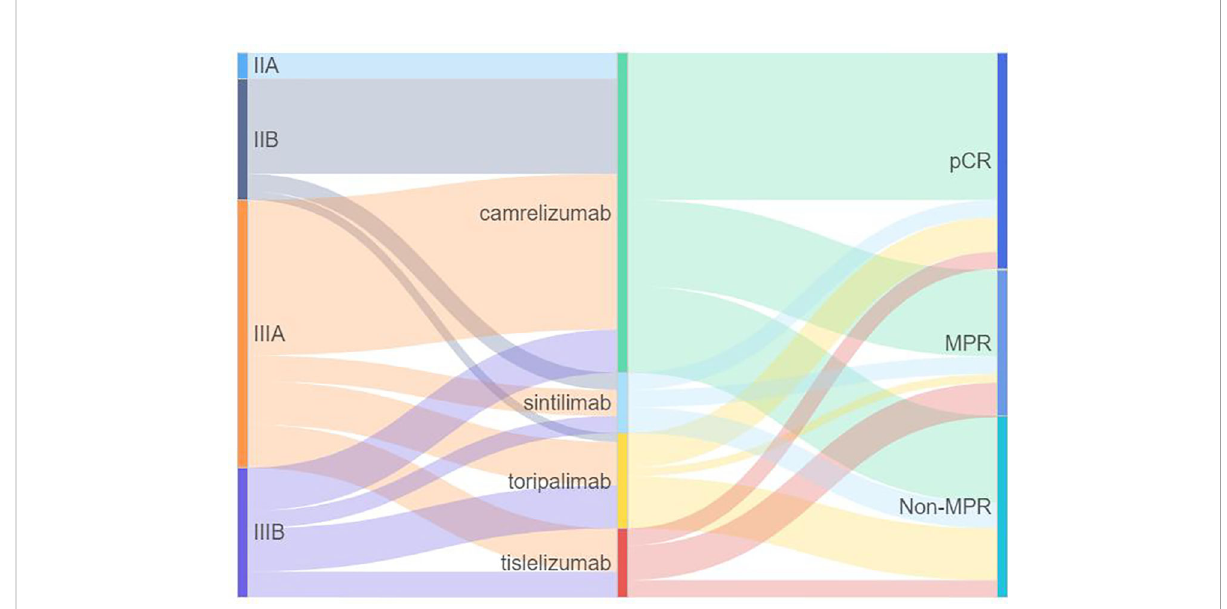
FIGURE 4 Sankey diagram of the relationship between pathological response of neoadjuvant therapy in different clinical stages. PD-1, programmed death 1; MPR, major pathologic response; pCR, pathologic complete response.